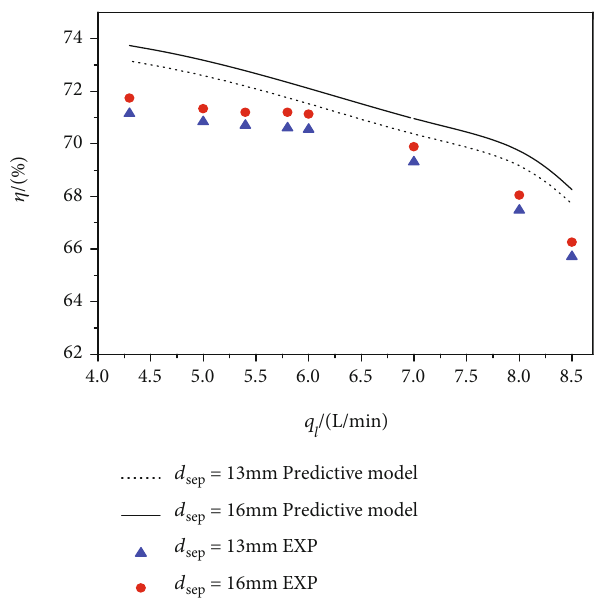
Figure 4: Comparison of separation e ffi ciency at di ff erent cylinder diameters.